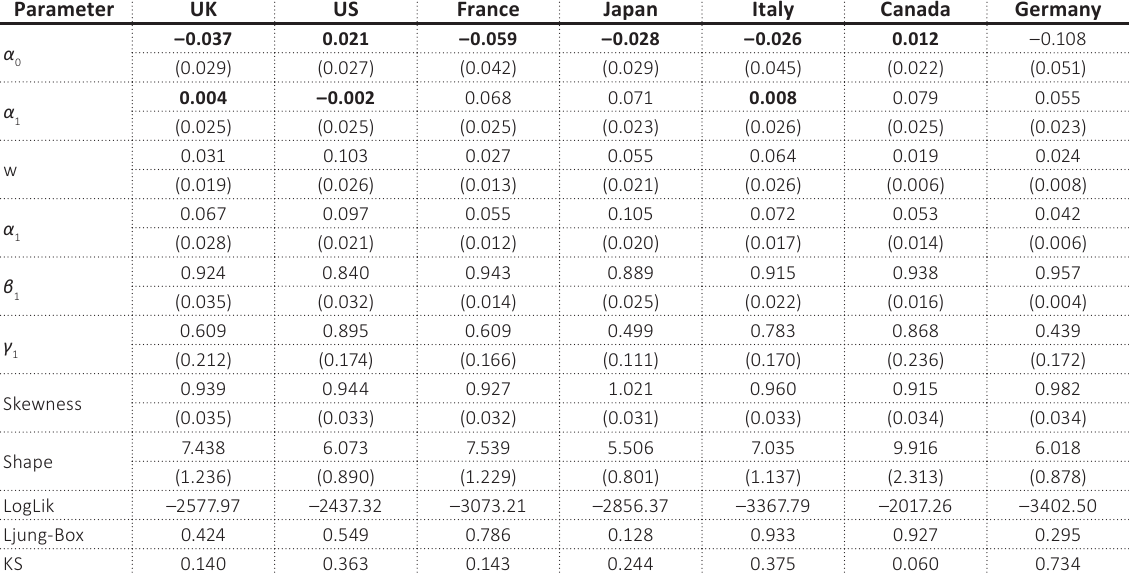
Table 2. Marginal distribution estimates